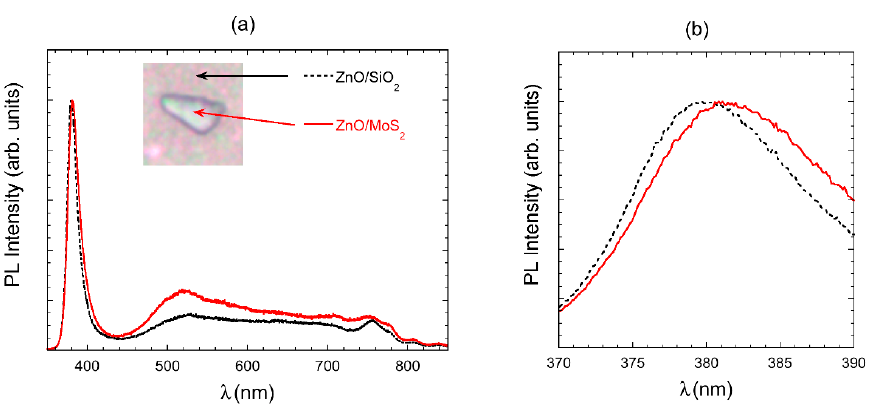
Figure 5. ( a ) Photoluminescence (PL) comparison of ZnO growth over MoS 2 and ZnO over SiO 2 . The inset reports the optical image of the scalene triangle, with the position of spectra acquisition. ( b ) Close up image of the near band emission (NBE).